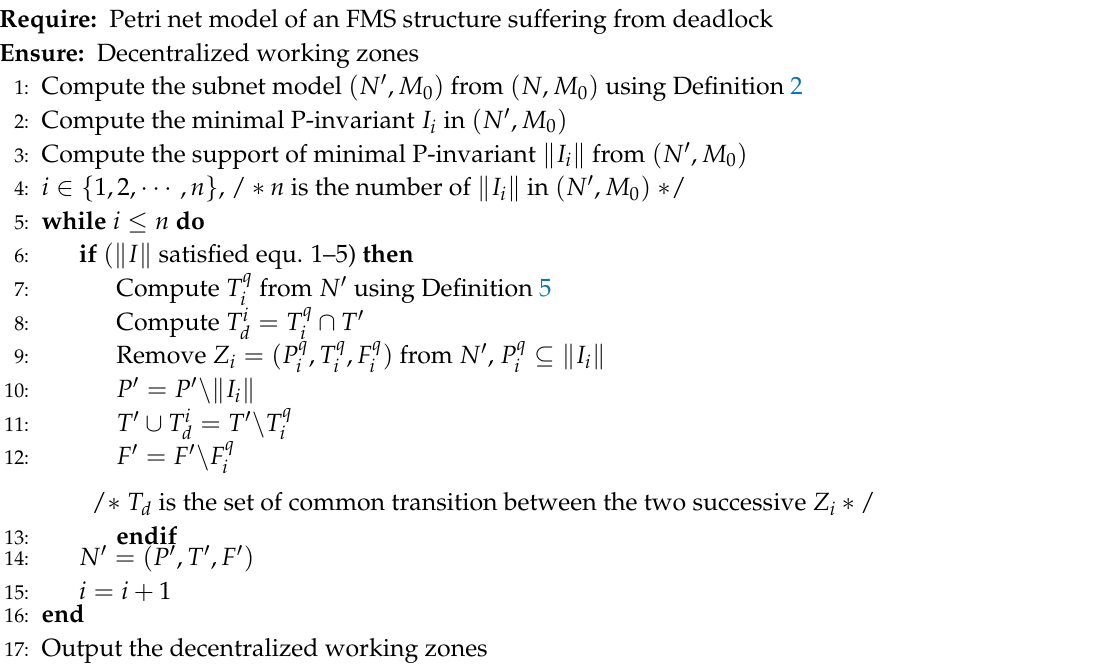
Algorithm 1 Decentralization of an FMS into working